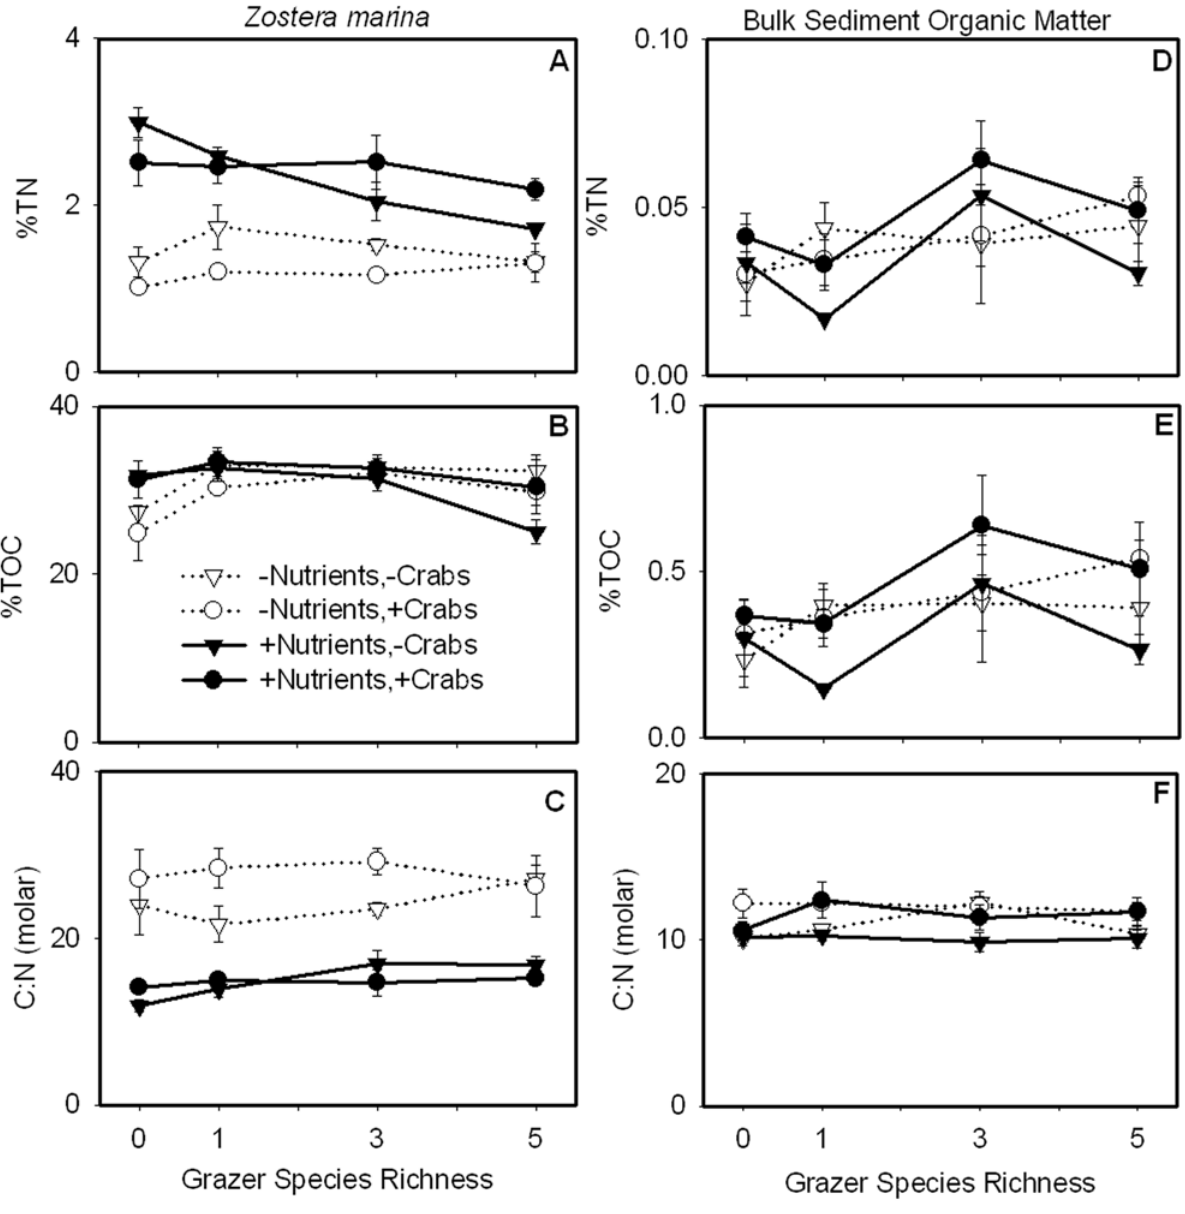
Figure 3. Stoichiometry of Z.marina (A–C) and bulk sediment organic matter (SOM; D–F). Z. marina %TN (A) was increased by nutrients and decreased by grazers while %TOC (B) was increased by grazers in unenriched treatments. Nutrient additions decreased C:N (mol:mol) and, hence, increased the nutritional quality of Z. marina (C). Grazer richness influenced SOM %TN (D) and %TOC (E) while crab predators increased %TOC and, consequently, C:N (F). As SOM had a lower C:N than Z. marina or macroalgae, it is likely that SOM derived from multiple sources of varying